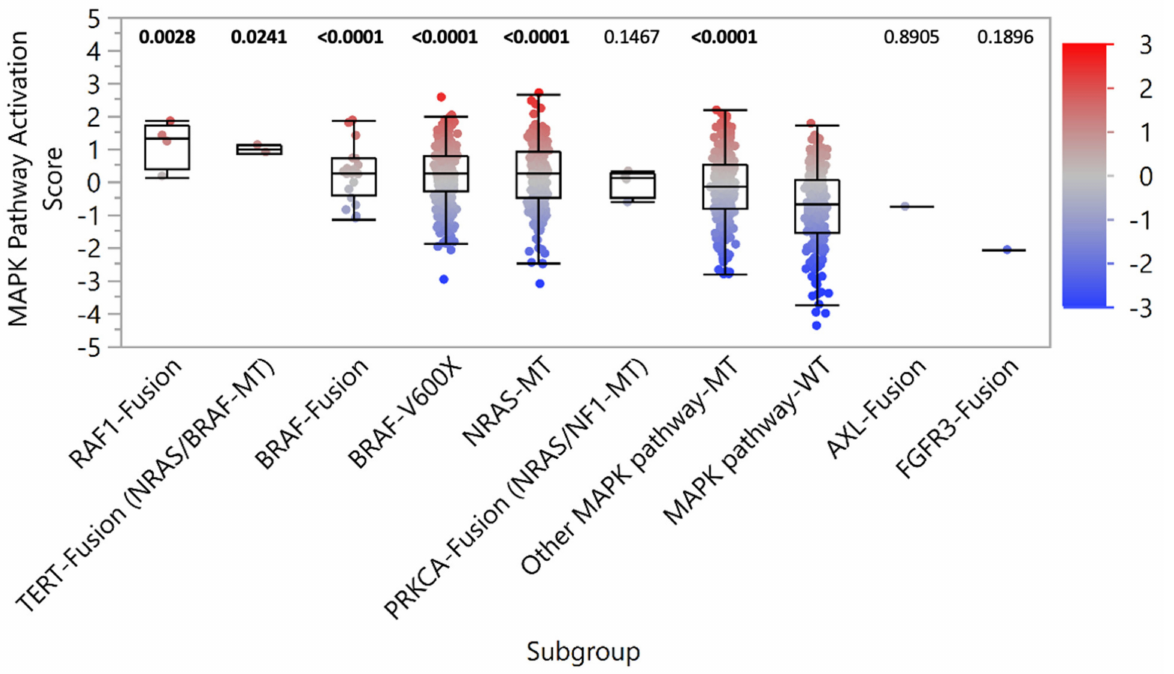
Figure 3. MAPK pathway activation. MAPK pathway activation scores were determined by the relative expression of key gene transcripts. Patient samples were stratified into subgroups based on the detection of pathogenic/likely pathogenic fusion or MAPK pathway alteration (co-alterations noted in parentheses). p -values (Mann-Whitney U) noted above each subgroup reflect the comparison with the MAPK pathway-WT control